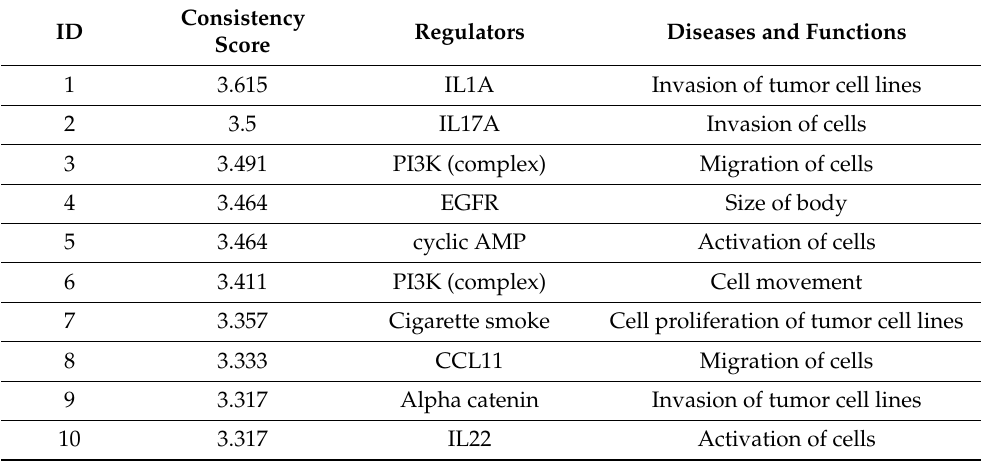
Table 2. Top 10 diseases and functions ranked by the consistency